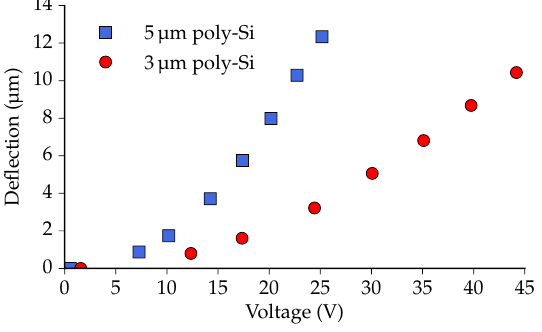
Figure 12. The vertical deflection of the center of the crossbar as a function of the actuator voltage.